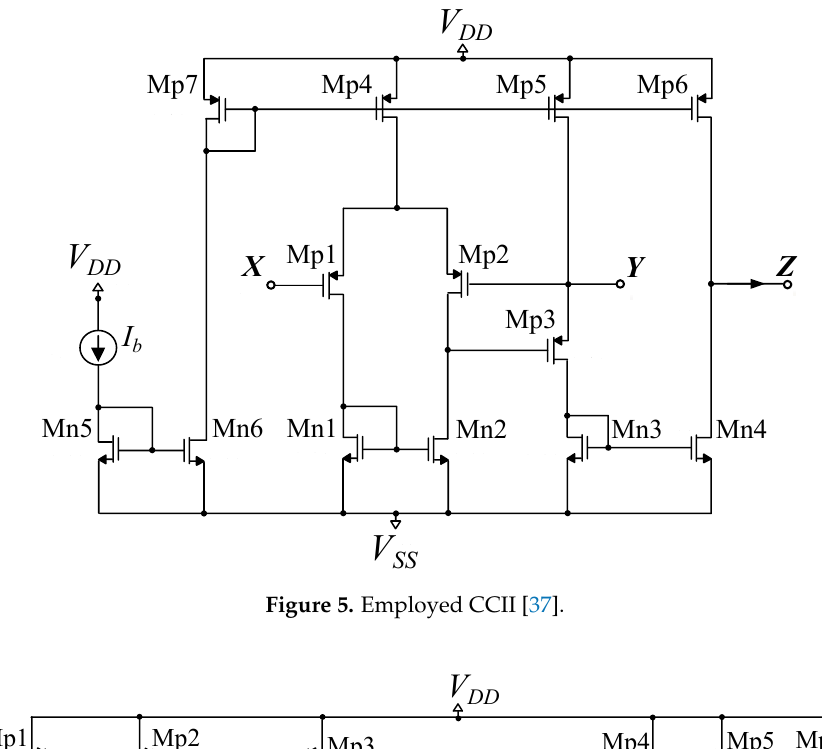
Figure 5. Employed CCII [37].